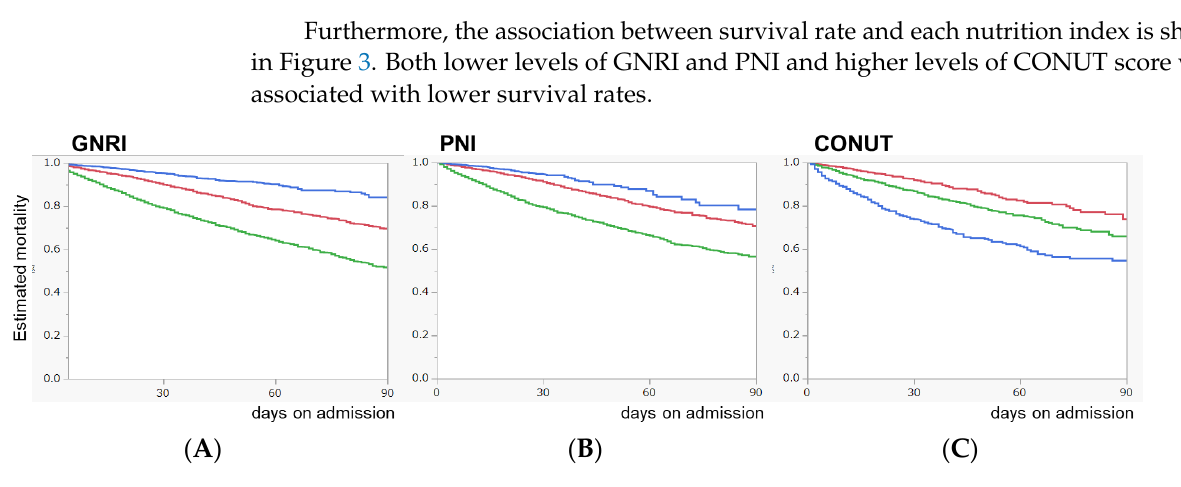
Figure 3. Survival curve of nutrition indices against mortality in sepsis. ( A ), GNRI (Geriatric Nutritional Risk Index). ( B ), PNI (Prognostic Nutritional Index). ( C ), CONUT (Controlling Nutrition Status).